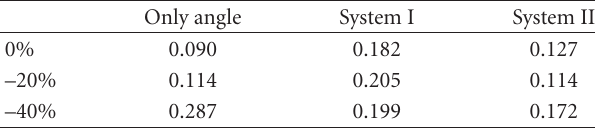
Figure 12: Error rate due to changes in